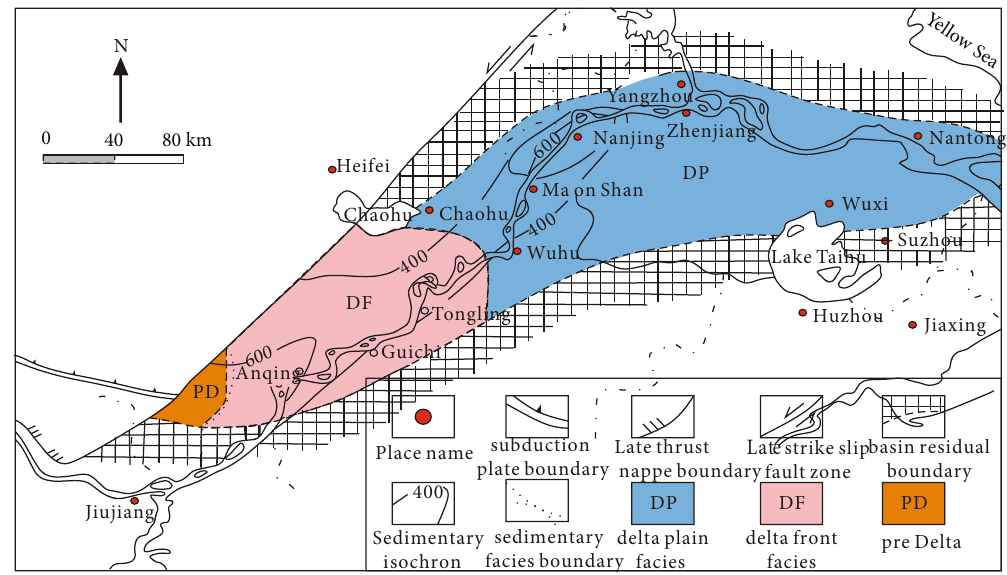
Figure 4: Sedimentary facies of Huangmaqing Formation in Jiangsu and Anhui